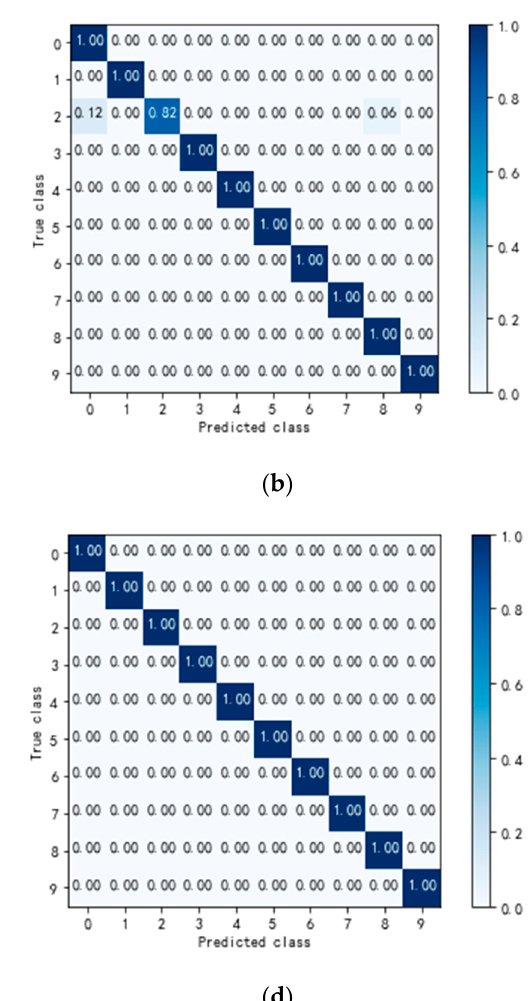
t-SNE is a dimension reduction algorithm that is based on manifold learning, which is different from the traditional PCA (Principal Component Analysis) and LDA (Linear Discriminant Analysis) methods. t-SNE uses normalized Gauss collated high-dimensional spatial data features for similarity modeling. At the same time, t-distribution is used in order to model the similarity of low-dimensional spatial data. KL distance narrows the distance distribution of high- and low-dimensional space and allows for visualizing